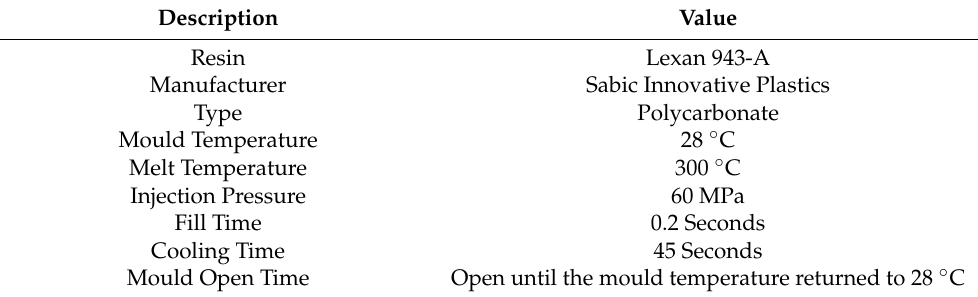
Figure 5. BabyPlast injection moulding machine with core and cavity 3DIM inserts assembled inside a MUD base and mounted onto the machine. Table 3. Process parameters used for injection